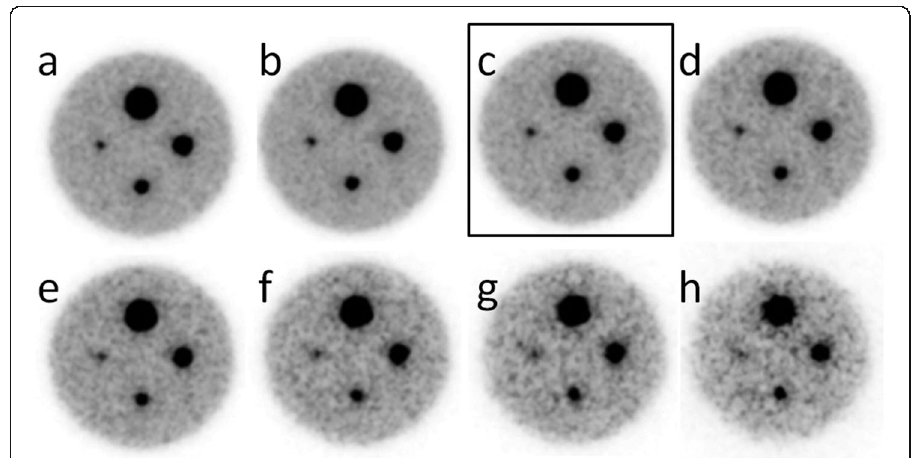
Fig. 2 Phantom images with different acquisition times created to determine the optimal acquisition time as a reference: a 840 s (200% dose), b 630 s (150% dose), c 420 s (100% dose), d 315 s (75% dose), e 210